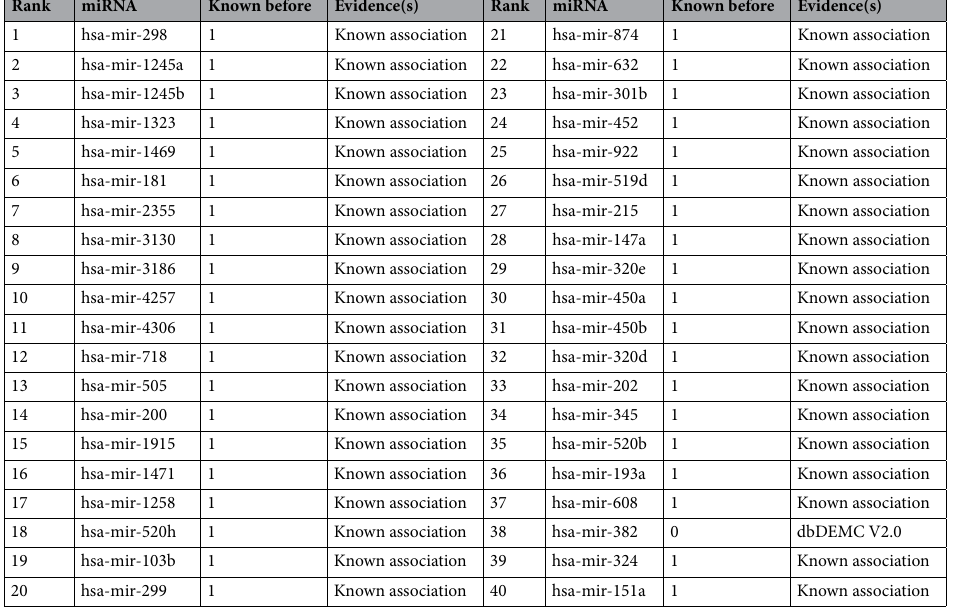
Table 3. Top 40 predicted breast neoplasms-associated miRNAs.